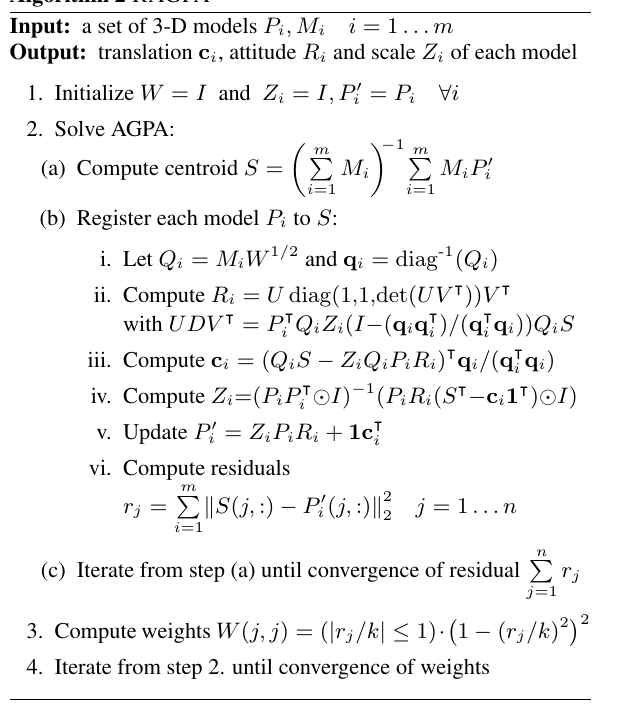
Algorithm 2 RAGPA